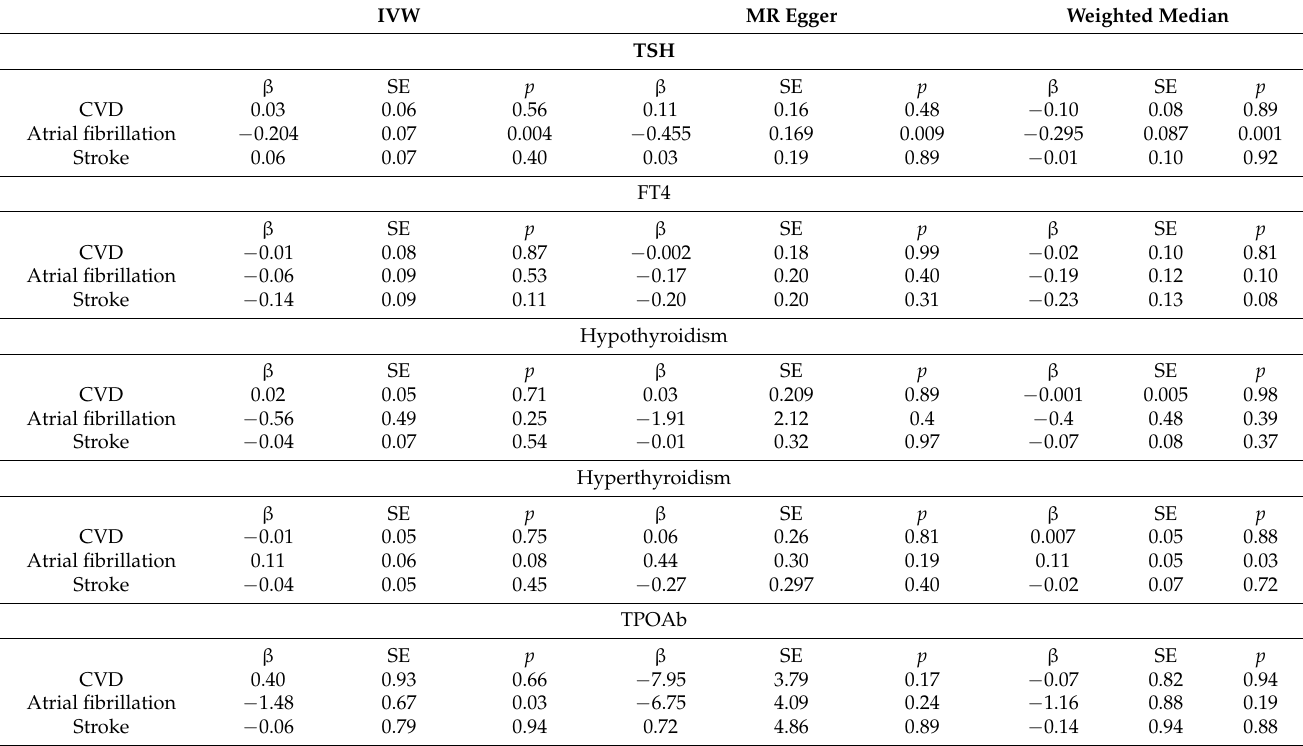
Table 2. Causal association between TSH and cardiovascular